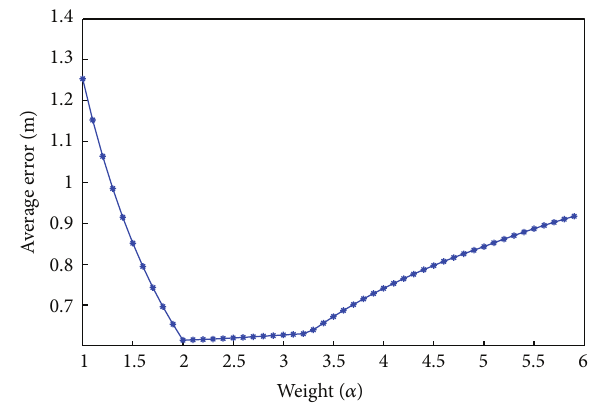
Figure 10: The dependence of weighting value on the average location estimation error for path 1.